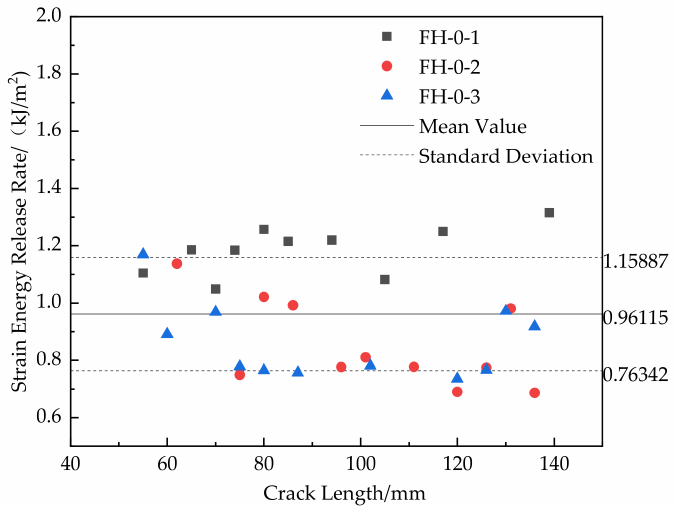
Figure 16. Release rate of critical strain energy of FH-0 with different crack lengths.